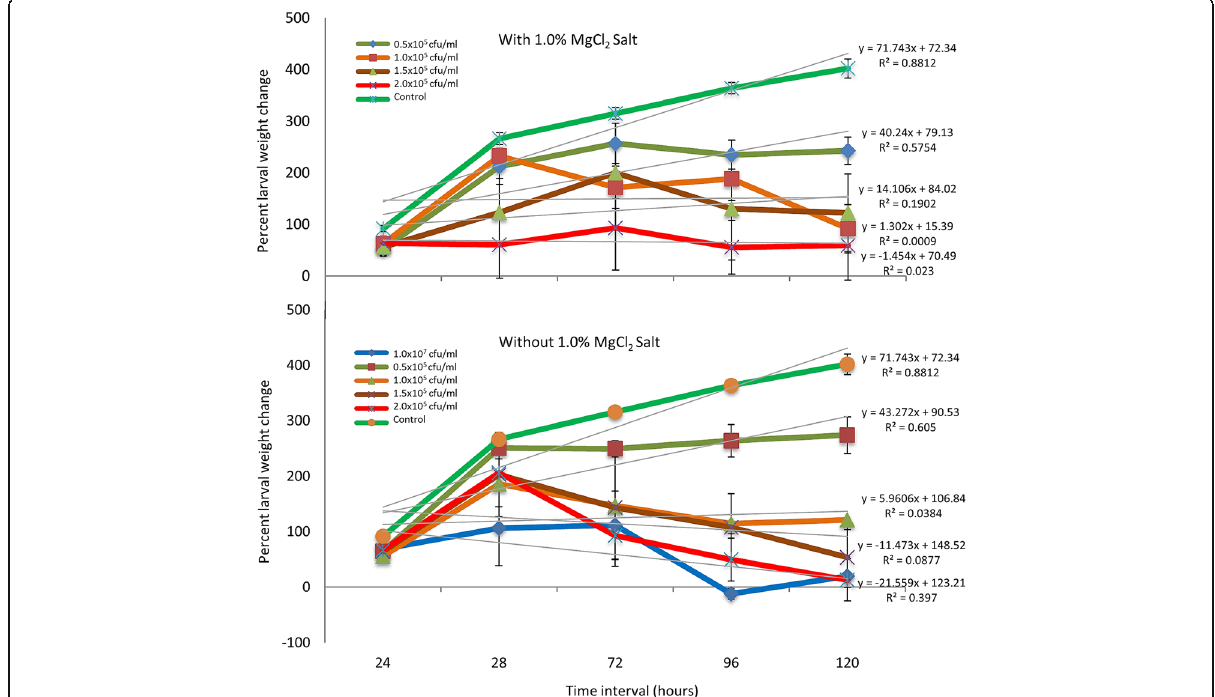
Fig. 2 Mean weight change of the third-instar larvae of Helicoverpa armigera Hübner exposed to different concentrations of Bacillus thuringiensis isolate with or without 1.0% MgCl2 salt. Data points represent mean percent weight change ± standard error ( n =